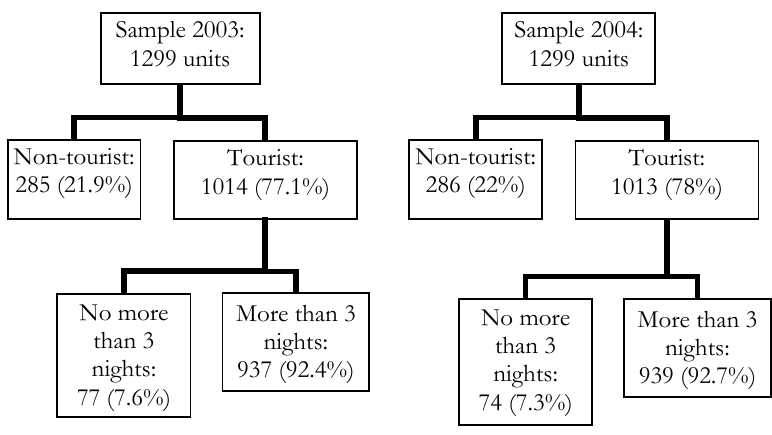
Figure 3 – General sample